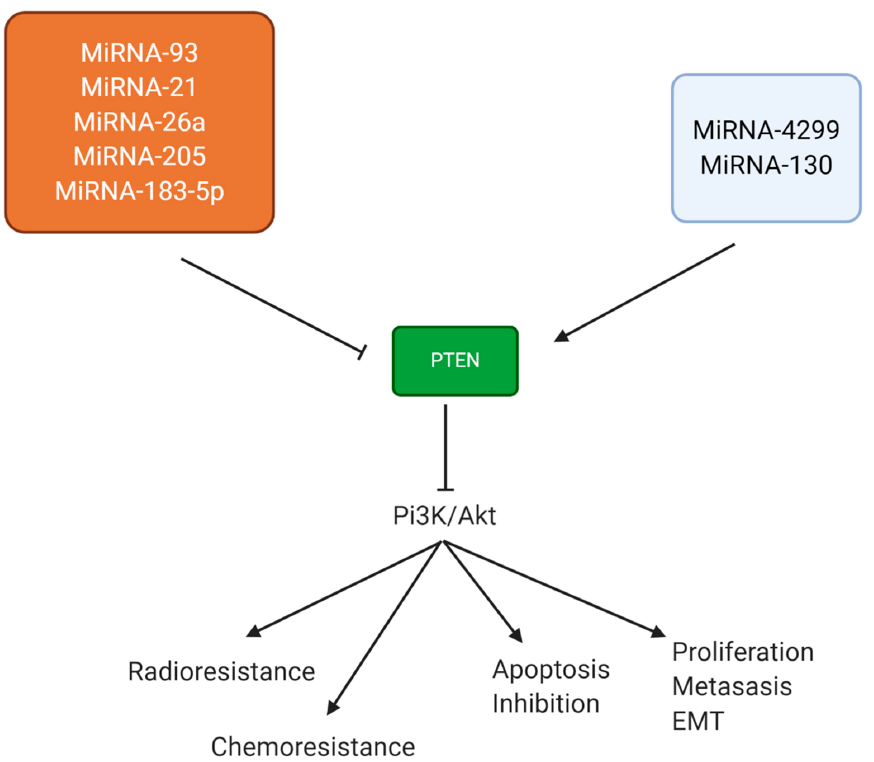
Figure 3. Radioresistance, chemoresistance, apoptosis, and metastasis of lung cancer cells are mainly affected by the miRNA/PTEN axis.